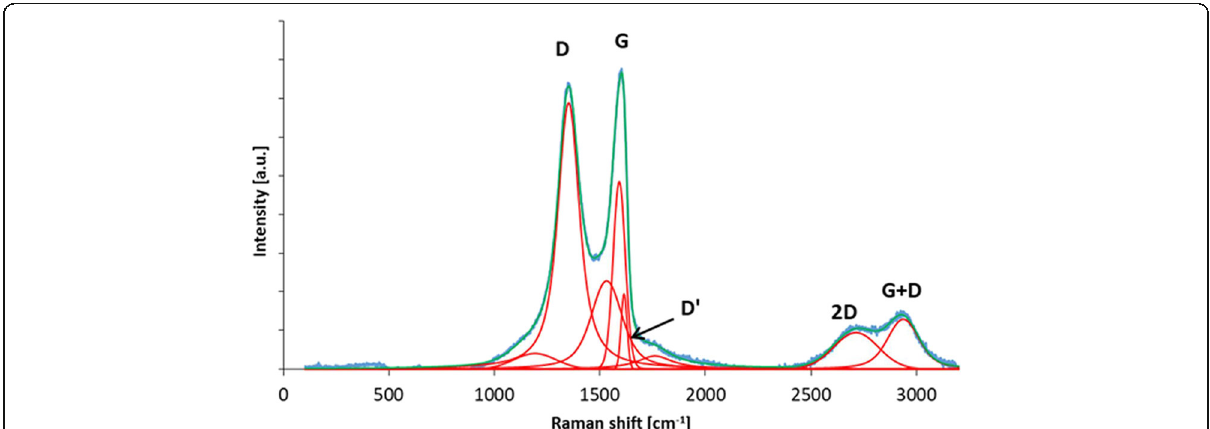
Fig. 2 Raman spectrum of graphene oxide with proposed deconvolution of the D, G, D ′ , 2D, and D +G bands. GO has a highly disordered structure due to many functional groups in the structure formed during oxidation of graphite powder. The position of the D band is 1351 cm − 1 and the G band 1590 cm − 1 ; the I D / I G ratio is